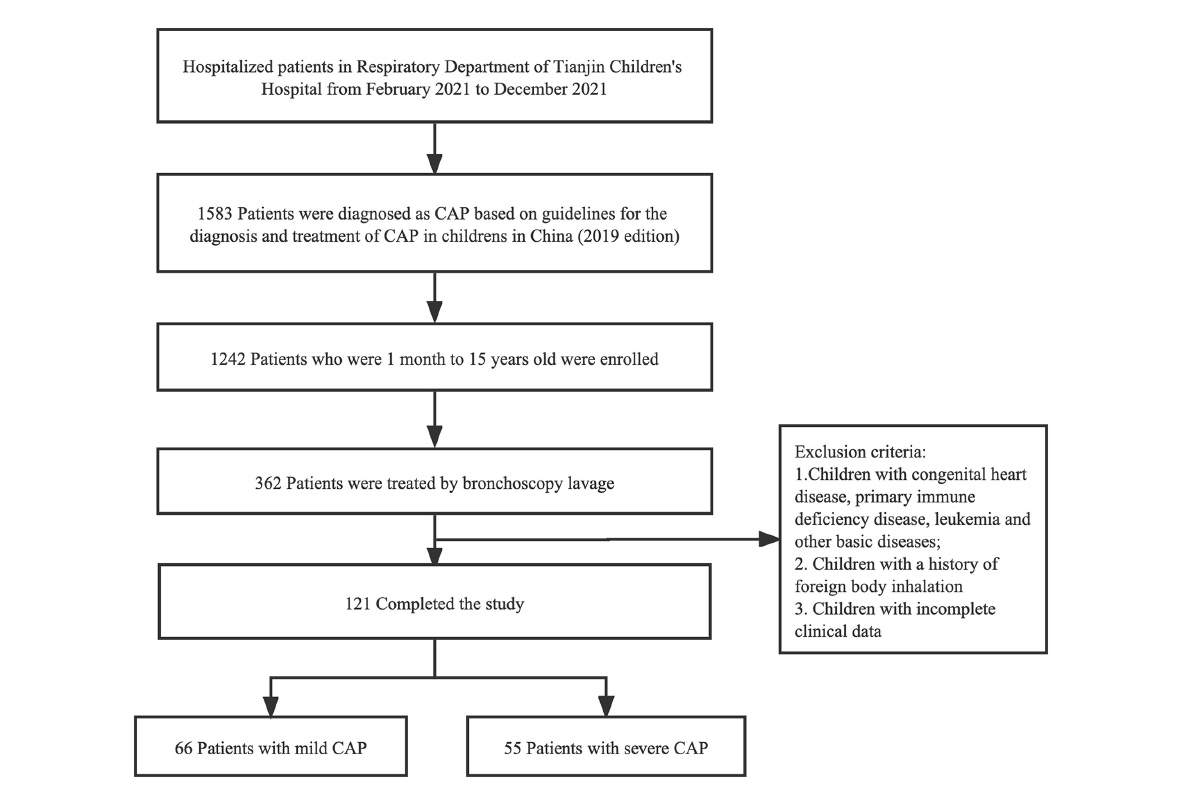
FIGURE1 Flowchart of case screening. One hundred twenty-one cases were selected in this study, and categorized into two groups defined as mild CAP group and severe CAP group. CAP, Community-acquired pneumonia.